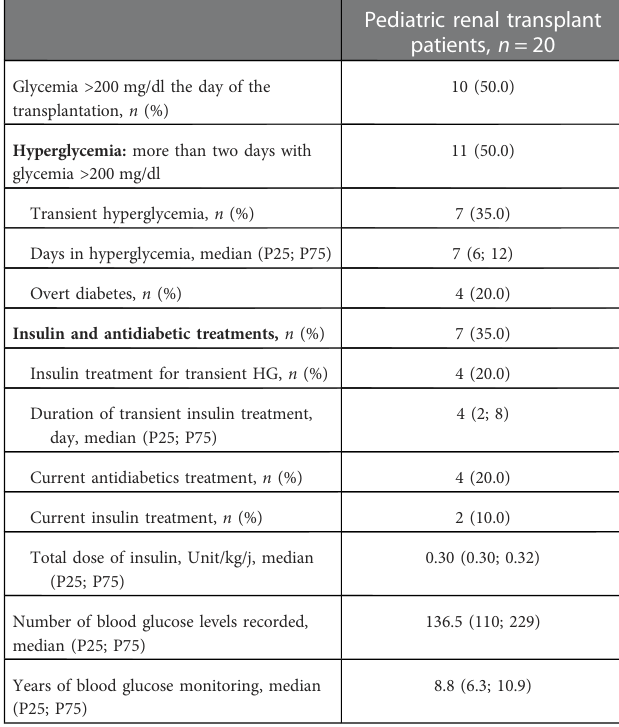
TABLE 6 Incidence of hyperglycemia and overt diabetes in RT cohort